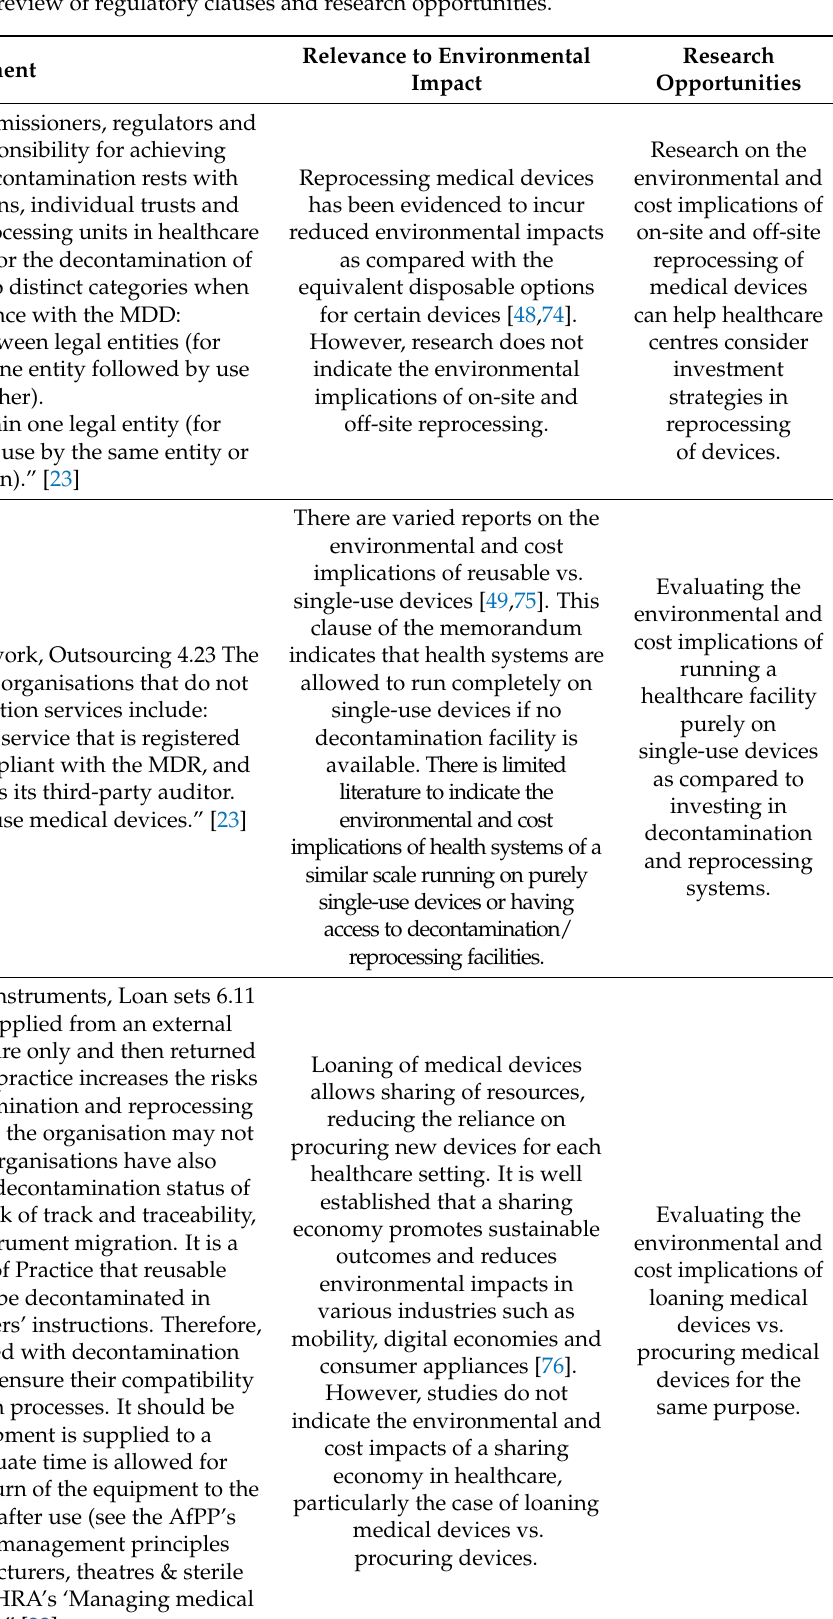
Table A1. Critical review of regulatory clauses and research